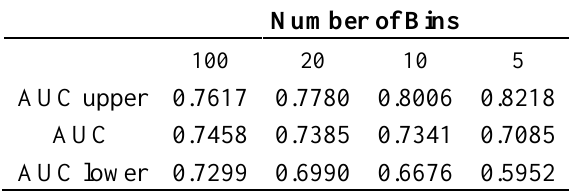
Table 3. Values of upper, trapezoidal, and lower AUC at various numbers of bins for the equal probability increment